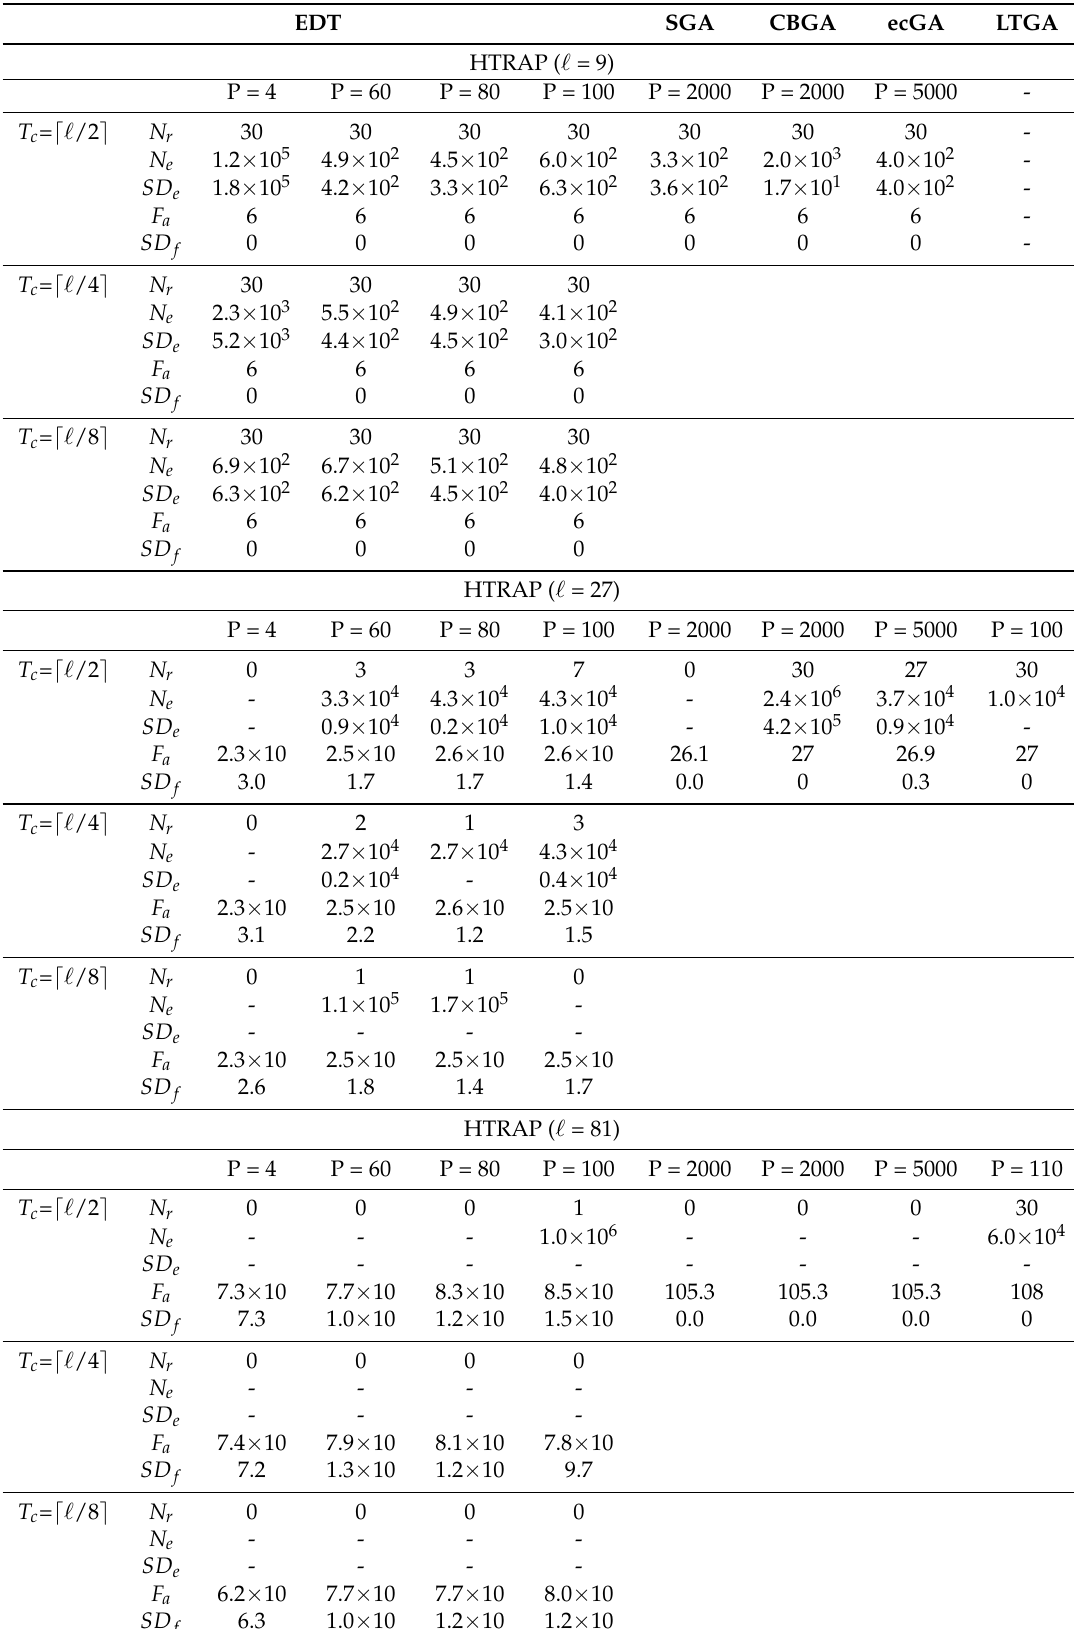
Table 3. The simulation results for